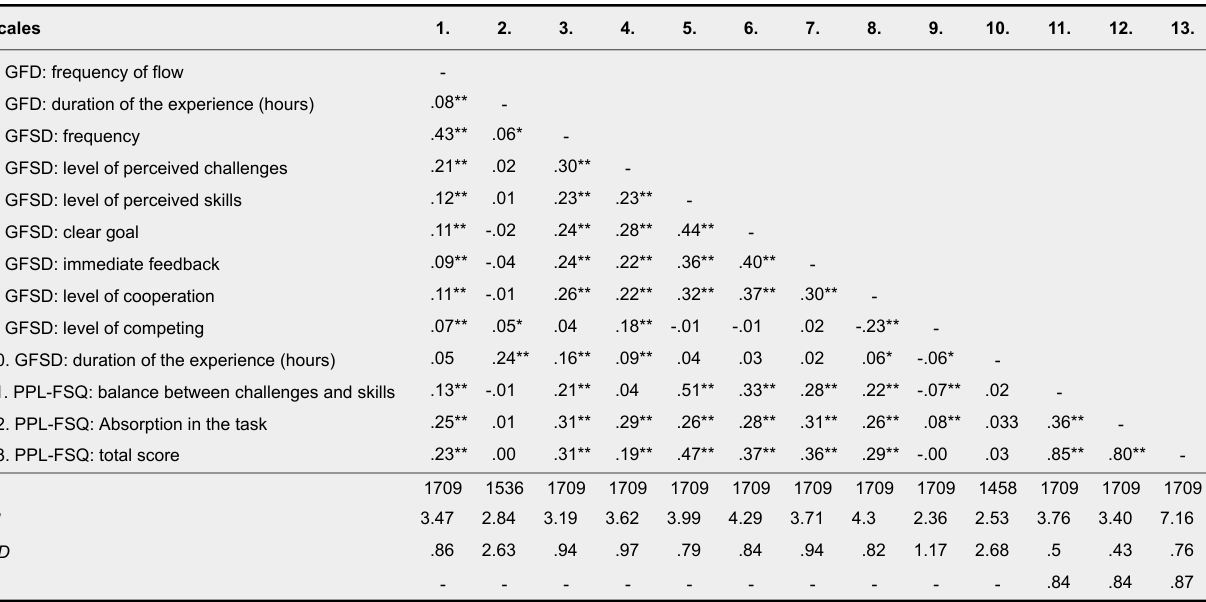
Descriptive Statistics of the Used Variables With